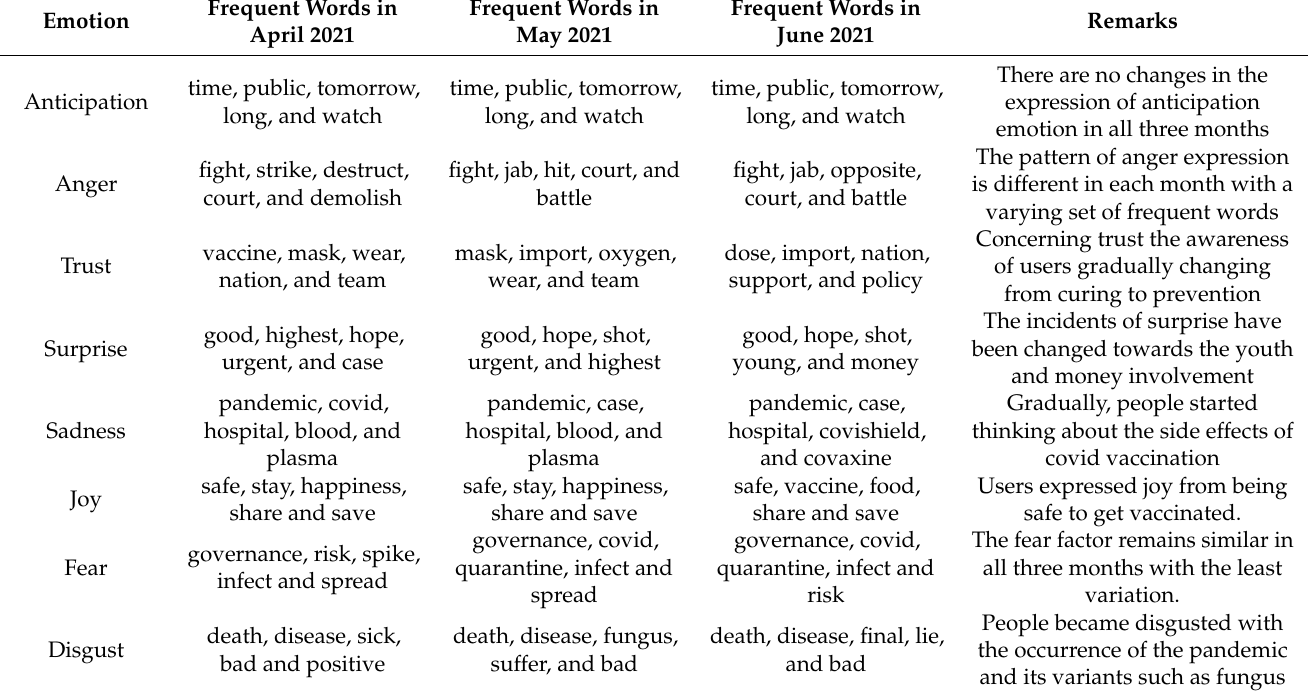
Table 3. Emotions and awareness of e-participation during infectious